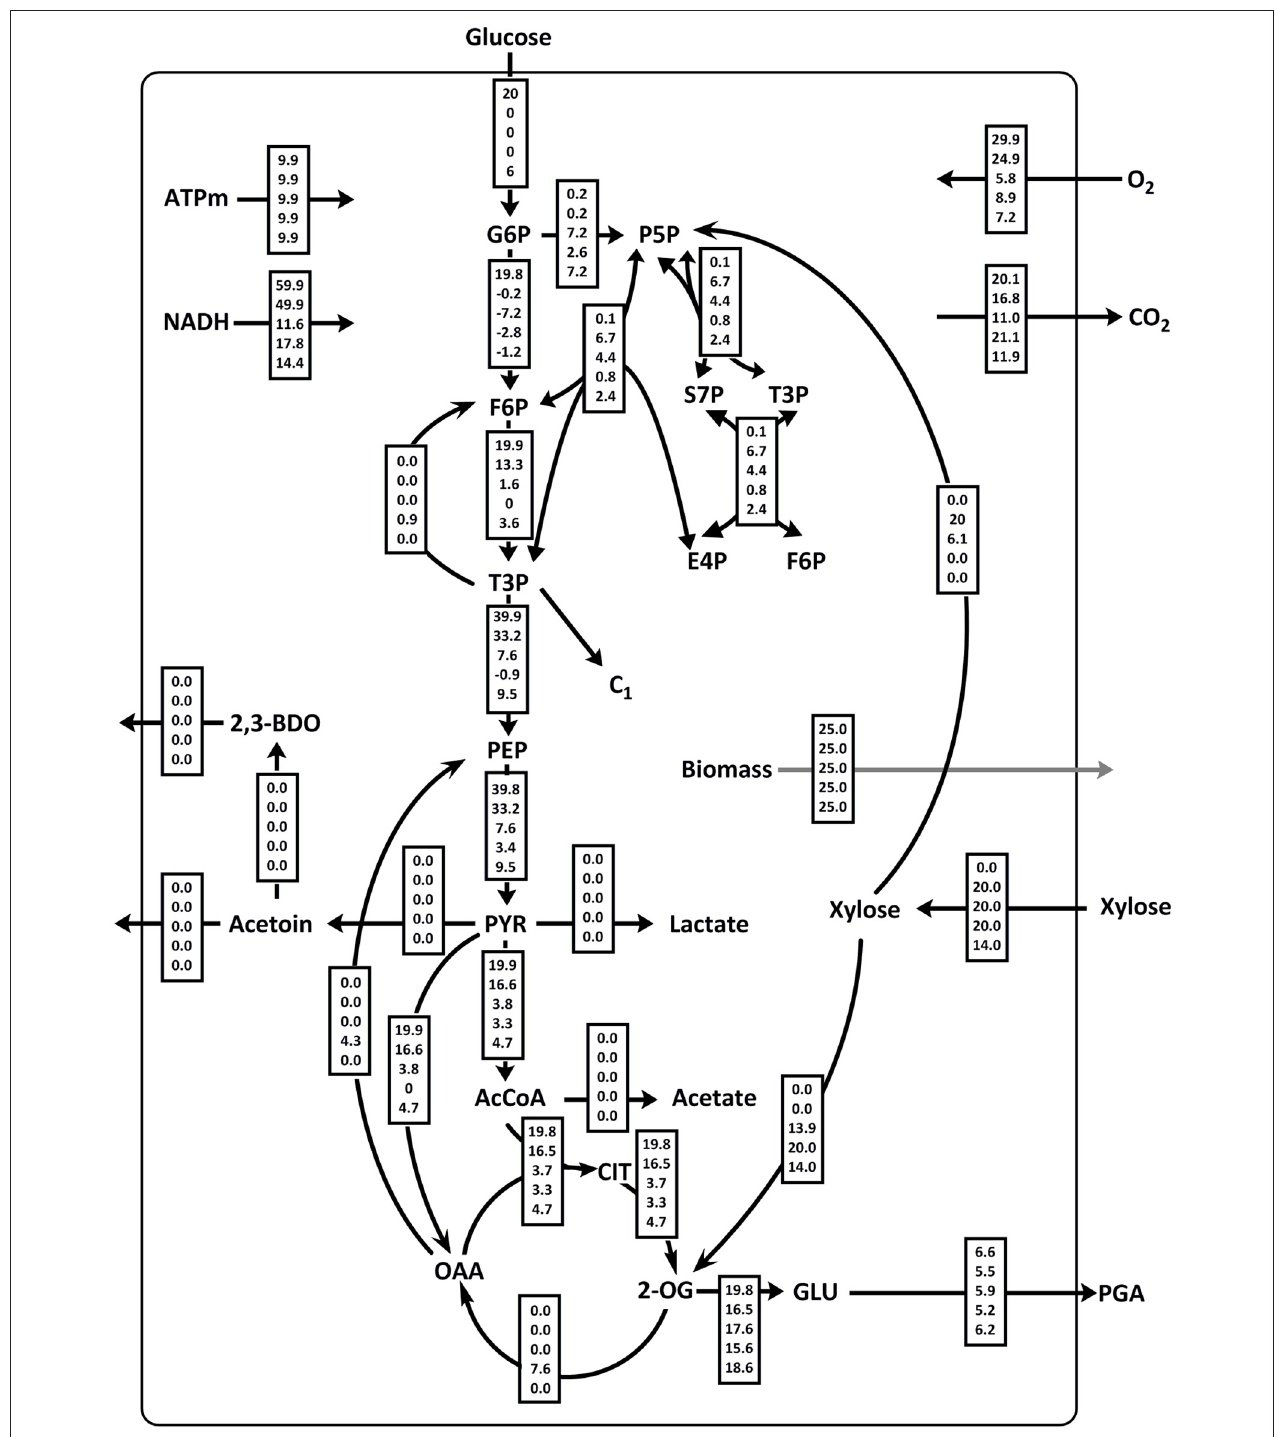
FIGURE 8 | Theoretical flux distributions for γ -PGA producing B. subtilis . Flux balance analysis (FBA) was used to calculate the fluxes for growth on glucose (1), xylose via isomerase pathway (2), xylose via isomerase and Weimberg pathway (3), xylose via Weimberg pathway (4), and a glucose/xylose mixture (5).